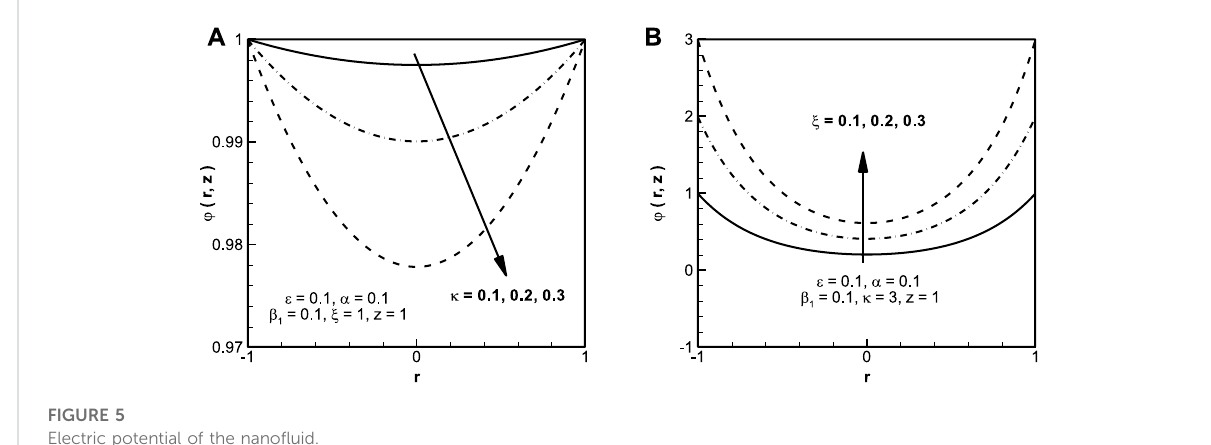
FIGURE 4 Temperature pro fi le of the nano fl uid.